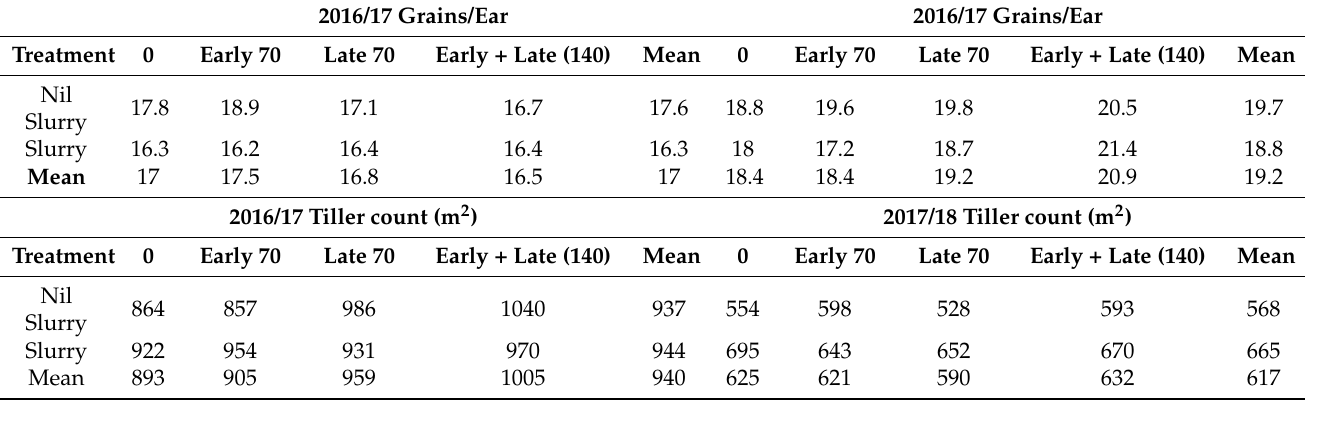
Table A4. 2016/17 and 2017/18 Means for grains/ear and tiller counts.